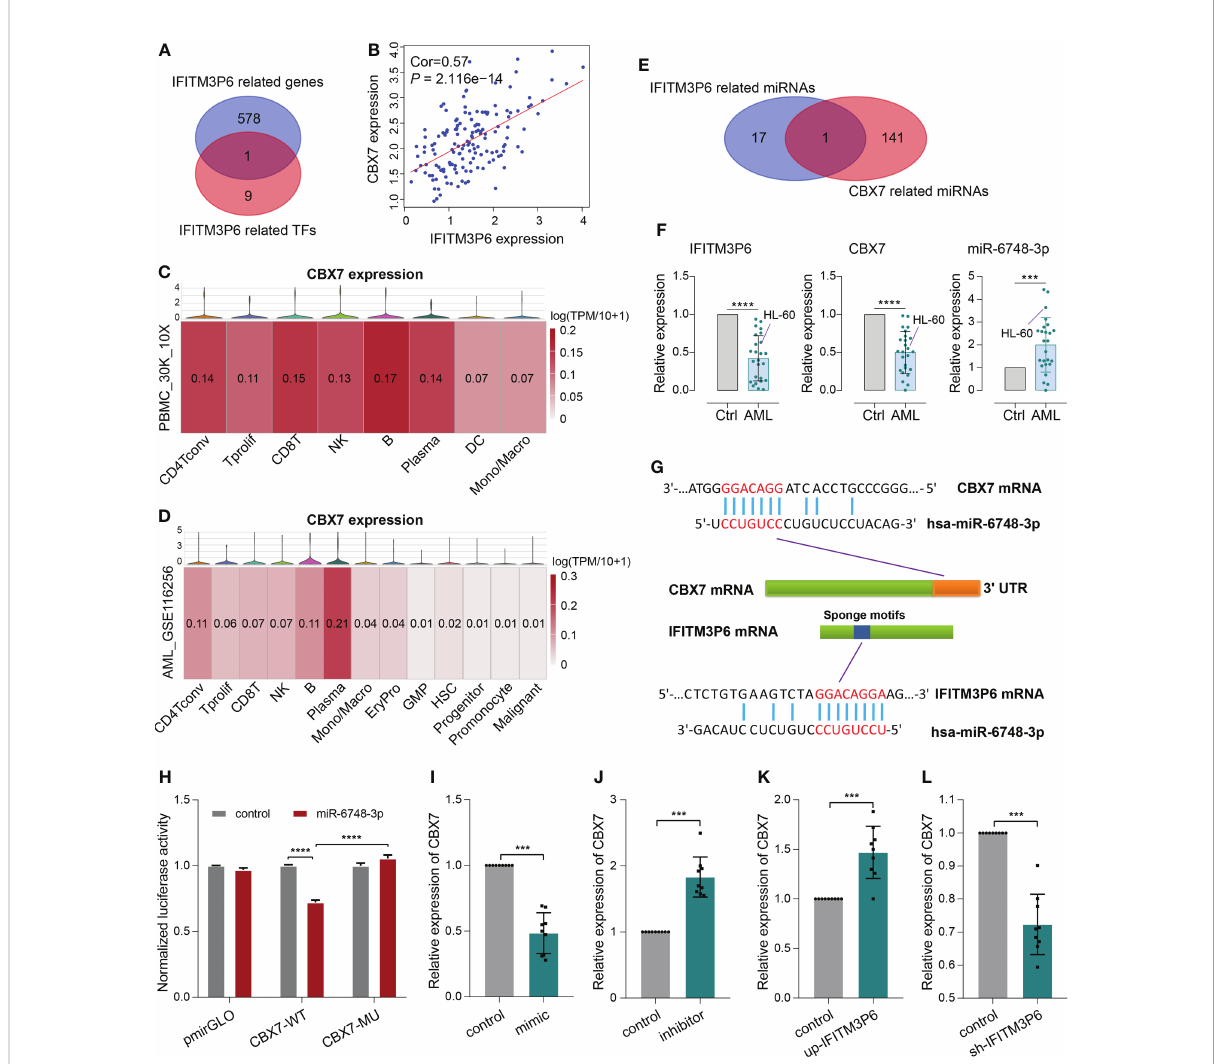
FIGURE 7 ceRNA mechanism detection of IFITM3P6 in T cell activation. (A, B) CBX7 was determined as a hub transcription factor that is computationally correlated with IFITM3P6. (C, D) Location of CBX7 in cell subtypes in healthy and AML single-cell transcriptome sequencing datasets. (E) Venn diagram of IFITM3P6- and CBX7-related miRNAs. (F) Relative expression of IFITM3P6, CBX7 and miR-6748-3p compared between the AML group and healthy control group. (G) Potential competing endogenous RNA (ceRNA) mechanism of IFITM3P6 and CBX7. (H) Dual-luciferase reporter assay revealed that miR-6748-3p could bind to the 3 ’ UTR of CBX7. (I, J) MiR-6748-3p expression was negatively correlated with CBX7 expression. (K, L) IFITM3P6 expression was positively correlated with CBX7 expression. *** p < 0.001; **** p <